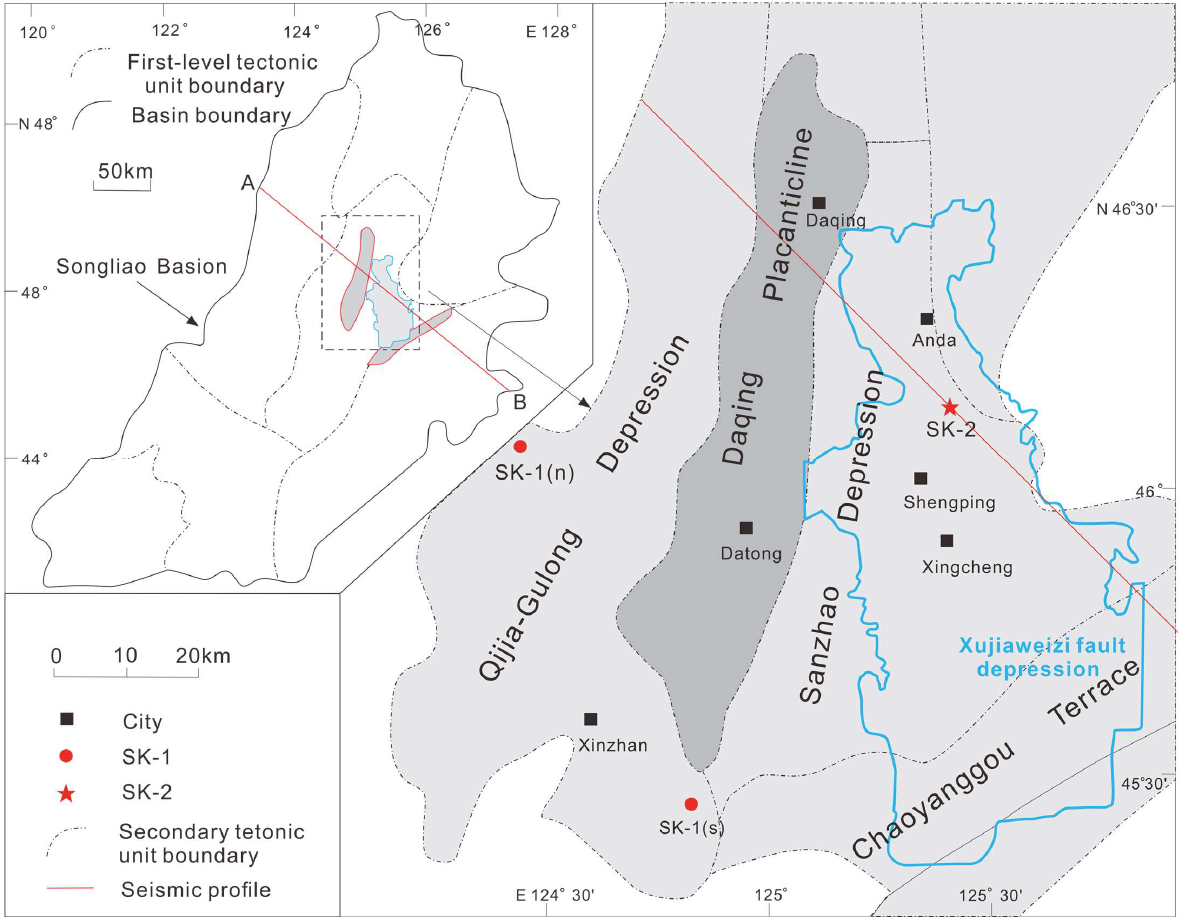
Figure 1. Geological and geographic setting of the Songliao Basin and the SK scientific drillings modified from